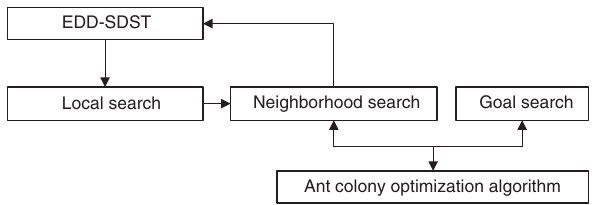
Figure 2: EDD-SDST-ACO Algorithm Relational